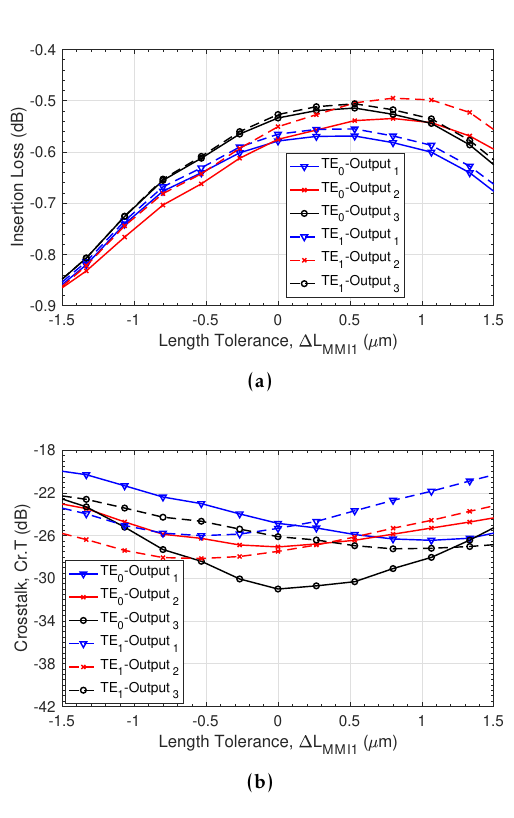
Figure 8. Insertion loss (a) and crosstalk (b) of the proposed switch as a function of the width tolerance.